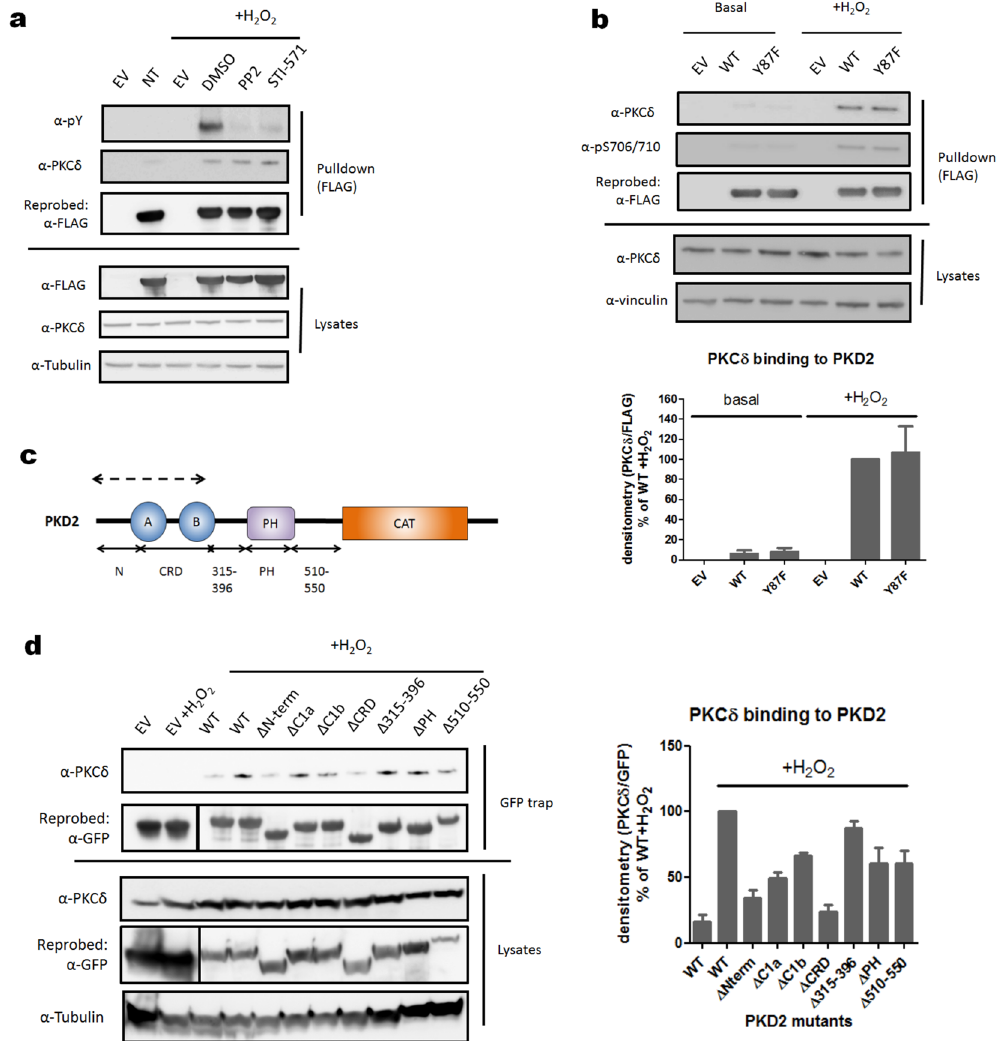
Figure 4. Different binding mode of PKC δ to PKD1 versus PKD2 in oxidative stress conditions. ( a ) Tyrosine kinase inhibition does not have an effect on the association between PKC δ and PKD2 during oxidative stress. HEK293 cells were transfected with wild type (WT) PKD2. 48 h after transfection, cells were treated with PP2 (10 µ M) or STI-571 (5 µ M) and subsequently stimulated with H 2 O 2 (10 mM, 10 min) and PKD2 was precipitated from the cells using FLAG antibody. Immunoprecipitates were subjected to western blot and probed with the indicated antibodies. Western blots were cropped for clarity; uncropped images can be found in Supplementary Fig. S15. ( b ) Tyr-87 phosphorylation is not required for the association between PKD2 and PKC δ . HEK293 cells were transfected with wild type (WT) PKD2 or the indicated mutants. 48 h after transfection cells were stimulated with H 2 O 2 (10 mM, 10 min) and PKD2 was precipitated from the cells using FLAG antibody. Immunoprecipitates were subjected to western blot and probed with the indicated antibodies. Quantification of three independent experiments is shown. Western blots were cropped for clarity; uncropped images can be found in Supplementary Fig. S16. ( c ) Schematic representation of PKD2 deletion mutants used for mapping the PKC δ binding domain. Deleted regions are denoted with full arrows. The proposed PKC δ binding region is indicated by a dotted arrow. ( d ) The N-terminal AP region and CRD of PKD2 are necessary for PKC δ interaction. HEK293 cells were transfected with wild type (WT) PKD2 or the indicated mutants. 48 h after transfection, cells were stimulated with H 2 O 2 (10 mM, 10 min) and PKD2 was precipitated from the cells via GFP trap. Immunoprecipitates were subjected to western blot and probed with the indicated antibodies. Quantification of three independent experiments is shown. Western blots were cropped for clarity; uncropped images can be found in Supplementary Fig.